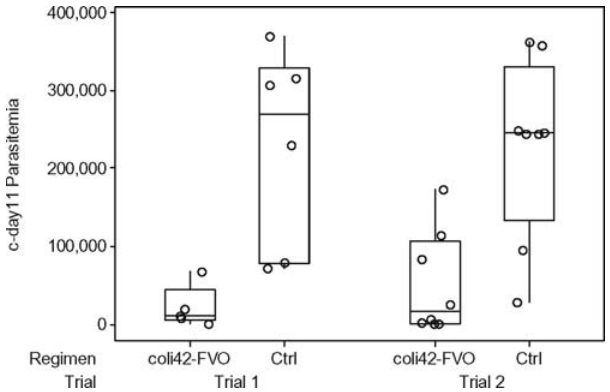
Figure 6. Responses in animals vaccinated with coli42-FVO/ ISA-720 or control. Shaded Open circles indicate individual responses, the boxed area shows defines the median and the second and third quartile responses, and whiskers define the first and